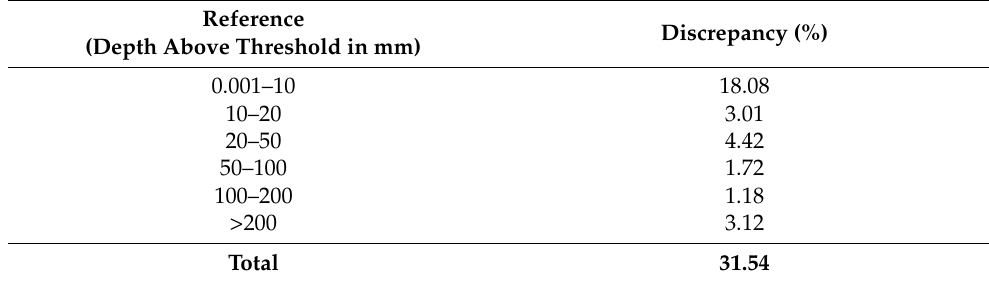
Table 4. Discrepancy distribution for non-flooded pixels for the two